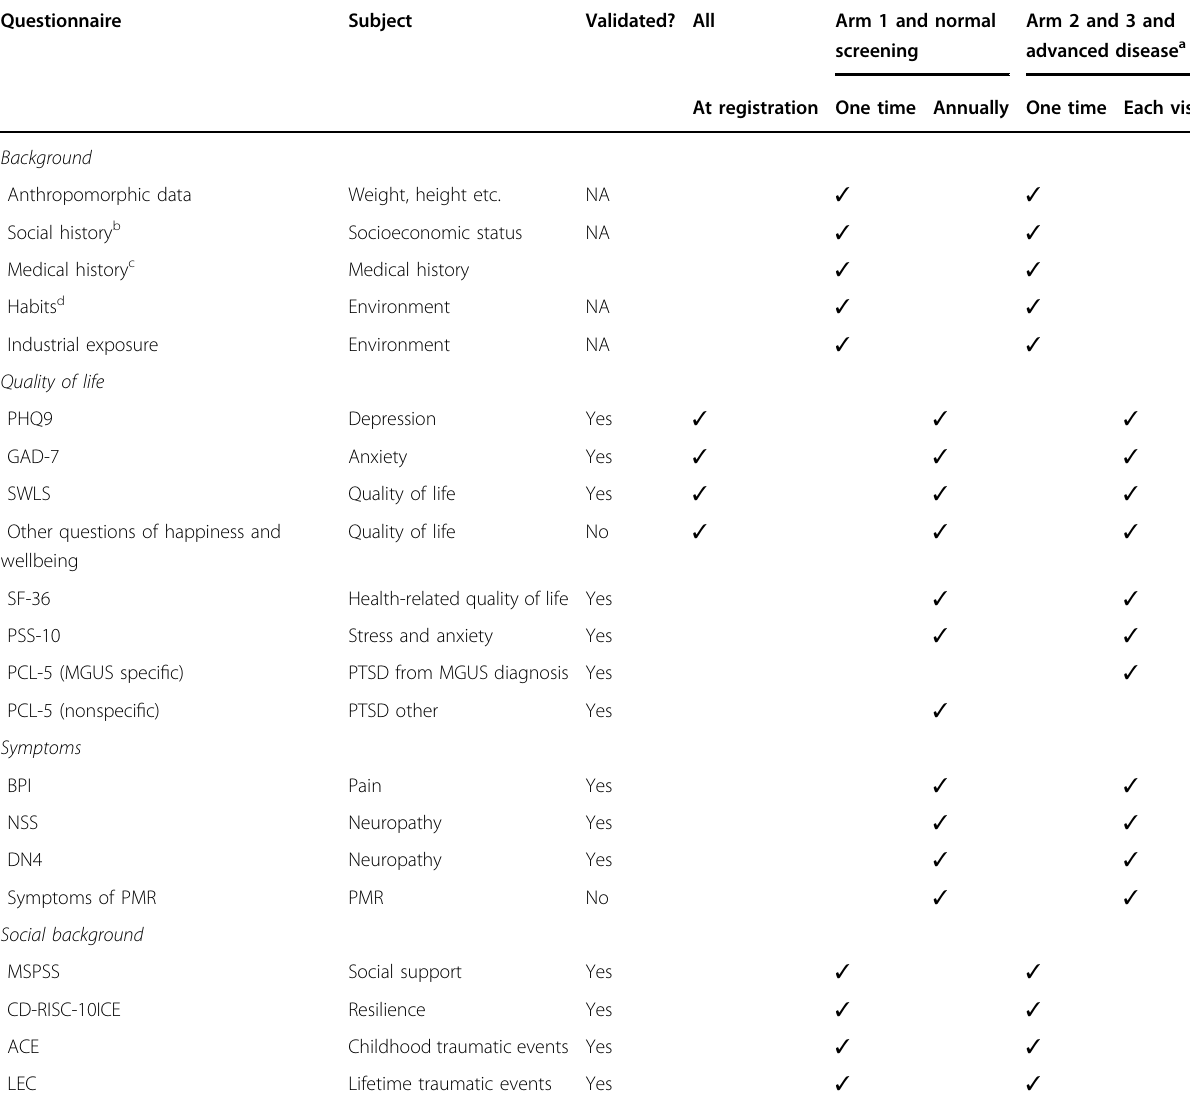
Table 2 Questionnaires sent to participants by email or answered at the study clinic.